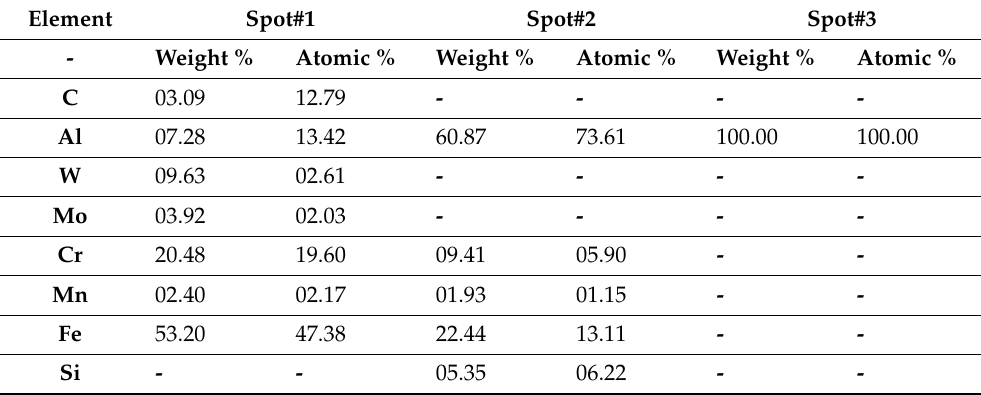
Table 5. EDX analysis results (Figure